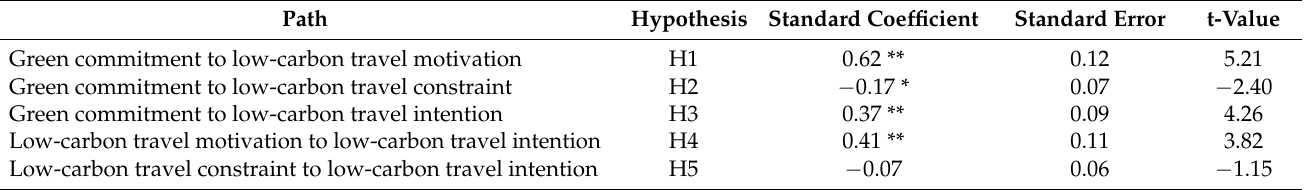
Table 3. Table of estimated parameters of hypothetical paths for theoretical structural models ( n = 358). Path Hypothesis Standard